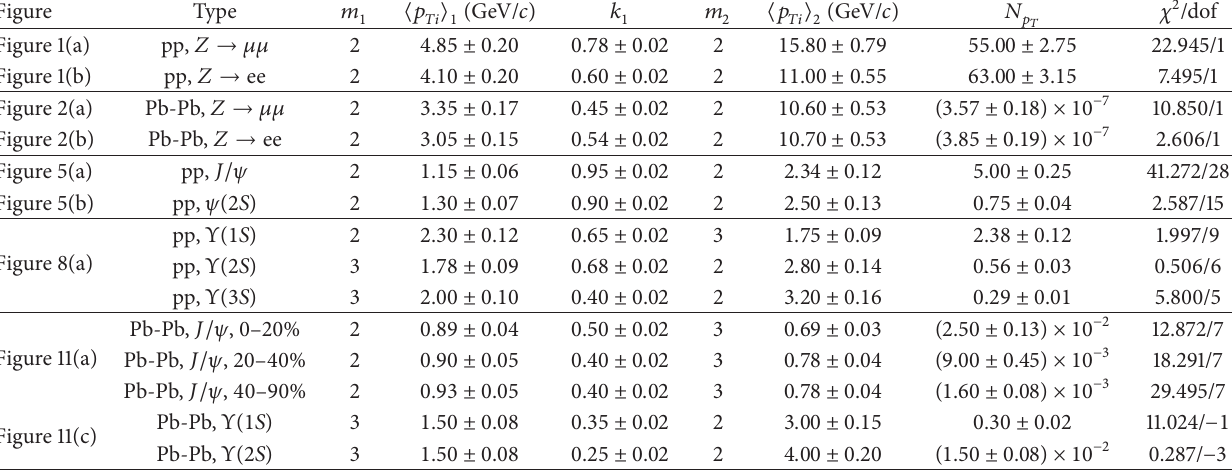
Table 1: Values of free parameters ( 𝑚 1 , ⟨𝑝 𝑇𝑖 ⟩ 1 , 𝑘 1 , 𝑚 2 , and ⟨𝑝 𝑇𝑖 ⟩ 2 ), normalization constant ( 𝑁 𝑝 component Erlang distribution in Figures 1(a), 1(b), 2(a), 2(b), 5(a), 5(b), 8(a), 11(a), and 11(c), where both the uncertainties on 𝑚 1 and 𝑚 2 are 0 which are not listed in the columns. In some cases, dof is less than 1.